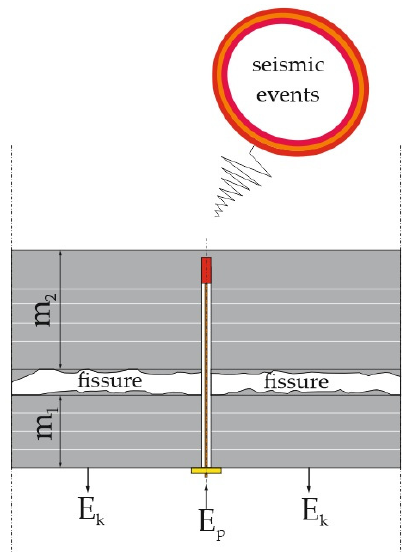
Figure 5. Impact load model for rock bolt support due to geomechanical seismic events.